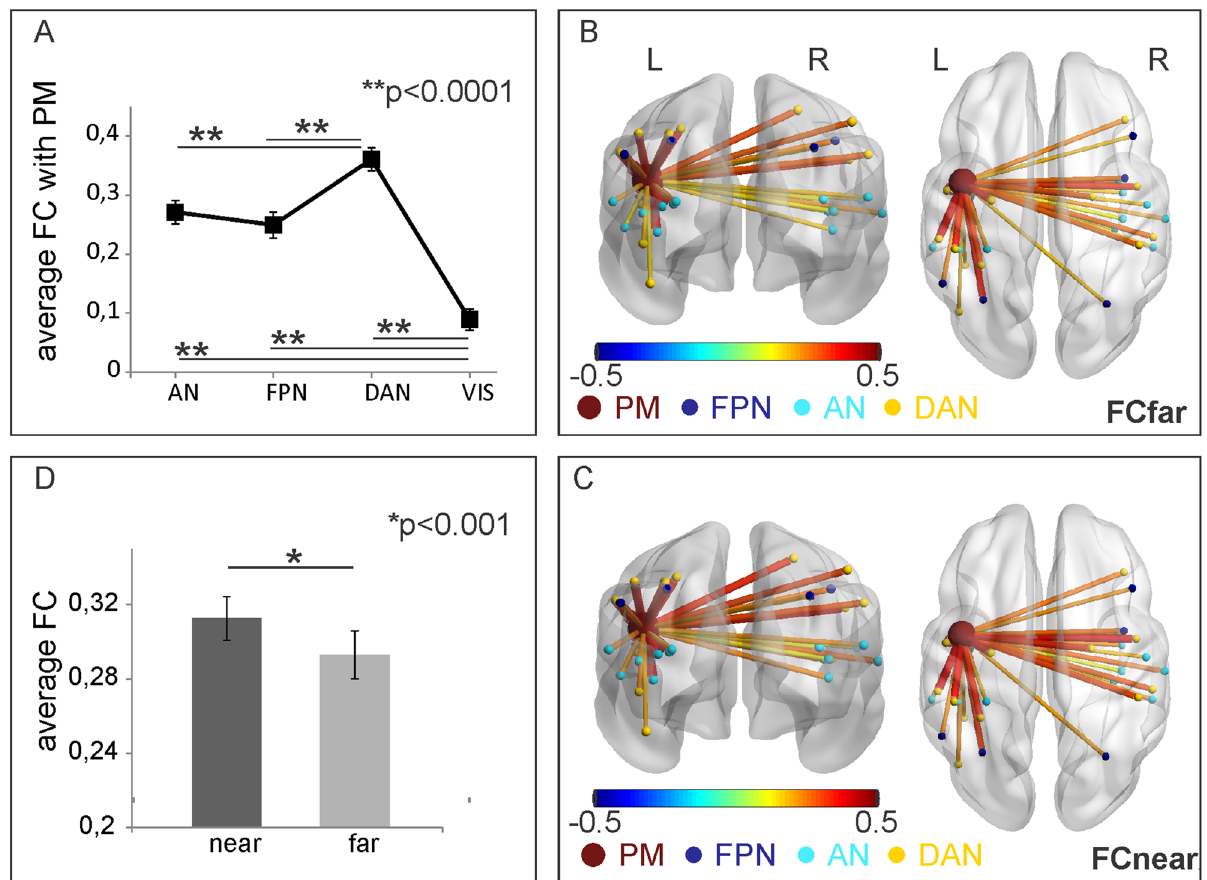
Figure 3. ( A ) Comparison among pairwise FCs between Premotor (PM) and task relevant regions (belonging to auditory network-AN, fronto-parietal network-FPN and dorsal attention network-DAN), and between Premotor and task irrelevant regions (belonging to visual network-VIS), as a control. ( B – D ) Results of background FC between PM and regions belonging to FPN, AN and DAN networks. Significant functional links are represented using lines on a standard brain in posterior and dorsal views. Line color and thickness represent the strength of connection during far ( B ) and near ( C ) space processing. ( D ) Average values of FC modulations across subjects and ROI pairs are shown as a bar plot together with the result of the two-sample t-test.